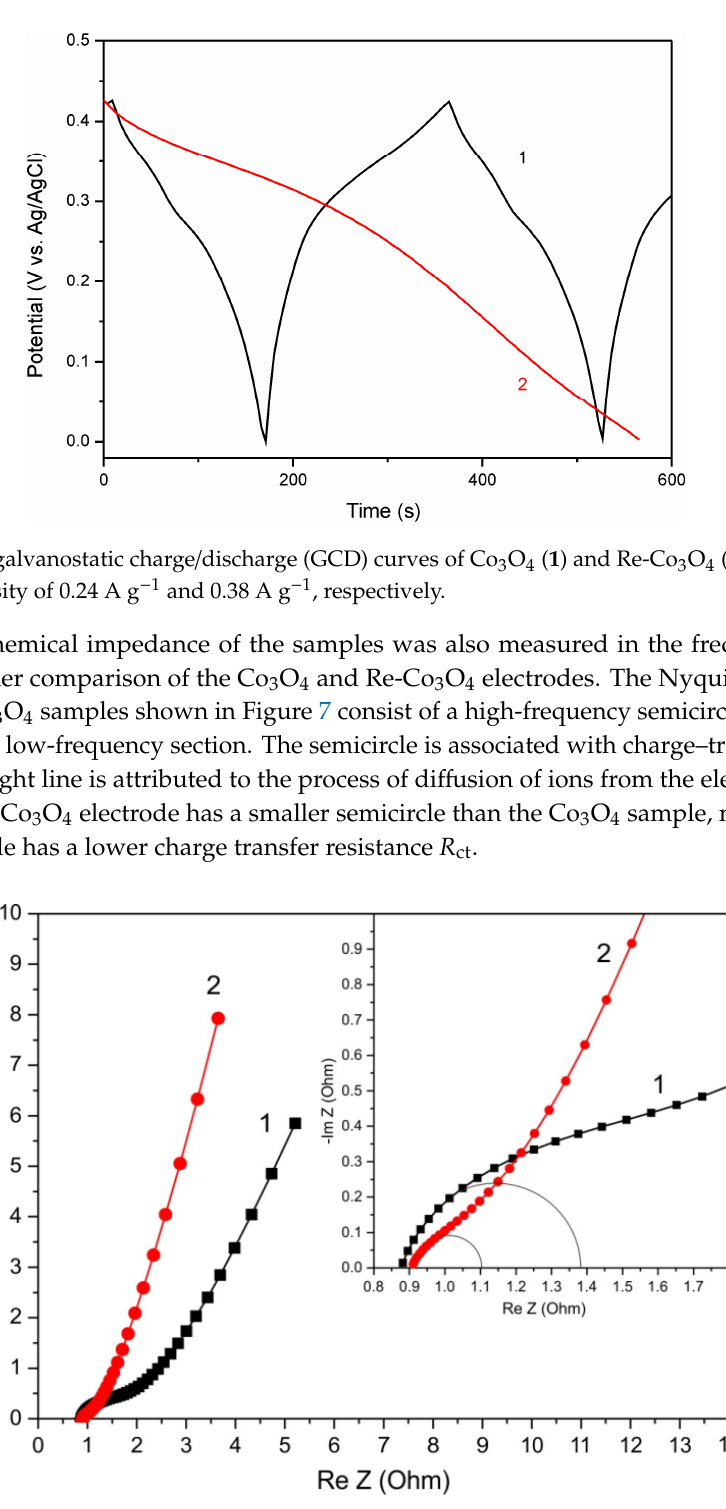
Figure 7. Nyquist plots of Co 3 O 4 ( 1 ) and Re-Co 3 O 4 ( 2 ) electrodes in the frequency range of 1–10 5 Hz; the inset indicates the Nyquist plots at high frequency region.